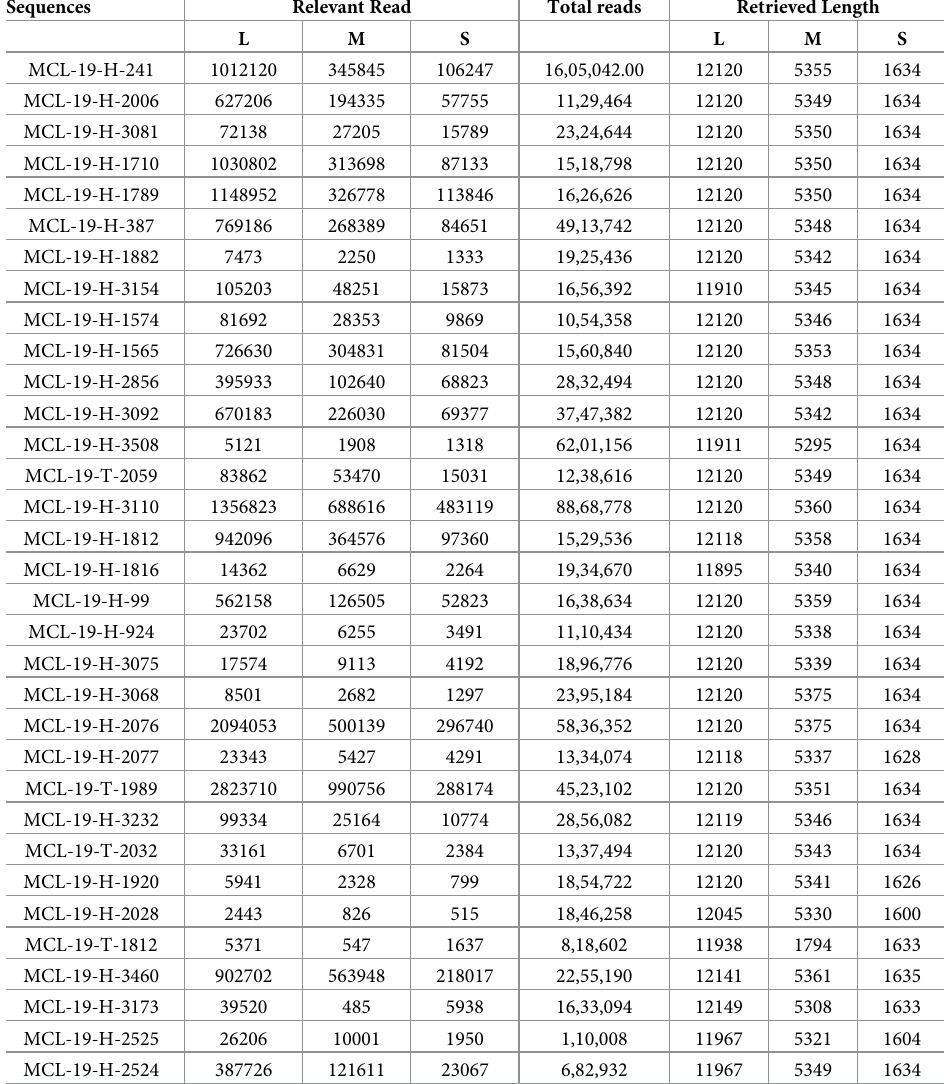
Table 3. The percentage of the genome recovered and the reads mapped for the each CCHFV sequences retrieved in this study. The NGS reads were mapped to the L gene (Accession No: KC867272), Asian M gene (Accession No: MN866207), African M gene (Accession No: MH396671), and S gene (Accession No: